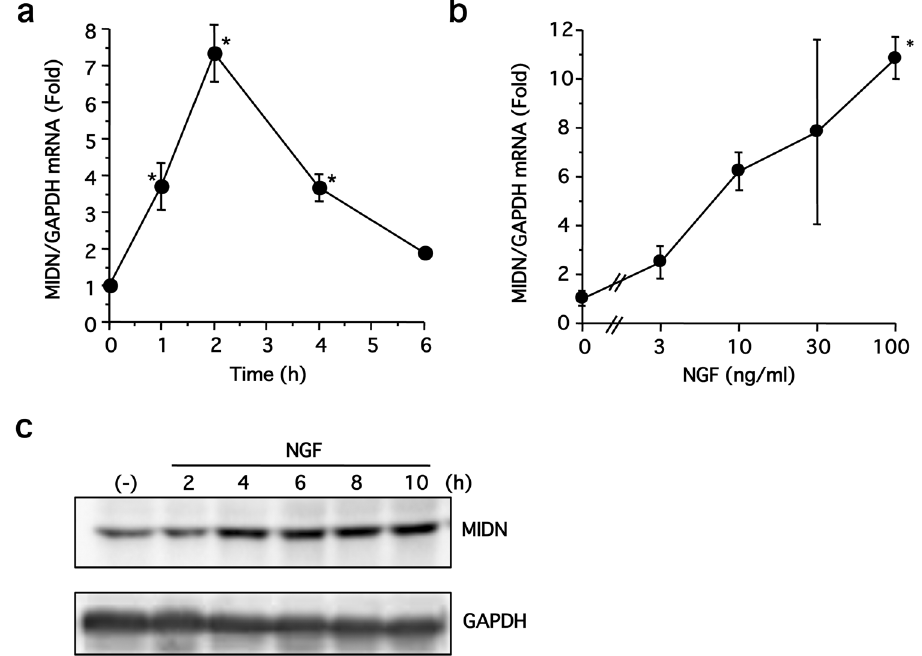
Figure 1. MIDN expression is induced by NGF in PC12 cells. ( a ) Serum-starved PC12 cells were stimulated with 100 ng/ml NGF for 1–6 h, as indicated, then MIDN gene expression was examined by qRT-PCR. NGF significantly induced MIDN gene expression compared with drug-free control ( * p < 0.05, n = 3). ( b ) Serum- starved PC12 cells were stimulated with 3–100 ng/ml NGF, as indicated, for 2 h, then MIDN gene expression was examined by qRT-PCR. NGF significantly induced MIDN gene expression compared with drug-free control ( * p < 0.05, n = 3). ( c ) Serum-starved PC12 cells were stimulated with 100 ng/ml NGF for 2–10 h, as indicated, and MIDN protein levels were examined by Western